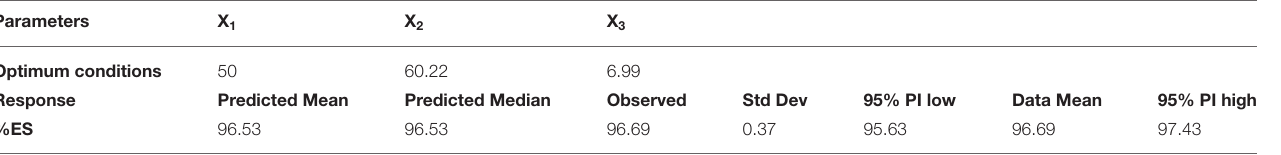
TABLE 4 | Experimental model